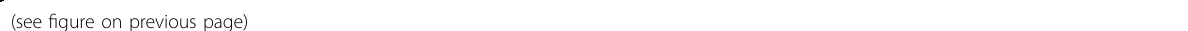
Fig. 5 Effect of C3G knock-down on EGFR activity and membrane localization. U87 and U87shC3G cells were used. A Representative western- blot analysis of phosphorylated and total levels of EGFR, ERKs, p38MAPK, and Akt proteins normalized to β -actin. Densitometric quanti fi cation of these proteins versus β -actin expressed as the fold increase of the value of untreated cells from the corresponding genotype (non-silenced and C3G silenced) ( n = 3). Untreated shC3G versus non-silenced cells ratios are: P-EGFR/ β -actin = 1, P-Akt/ β -actin = 2, P-ERKs/ β -actin = 1.6, P-p38MAPK/ β -actin = 2.6. Serum-starved cells (for 16 h) were stimulated with EGF for 5 – 60 min or maintained untreated. B Invasion through Matrigel in response to EGF. Upper panel, representative phase contrast microscopy images of invading cells; lower panel, histogram showing the mean value ± S.E.M. of the total number of invading cells ( n = 3). Scale bars: 100 µm. C Top panel, representative fl uorescence microscopy images of EGFR endocytosis mediated by EGF labeled with Alexa 488 (EGF-A488, green ) at different time points; lower panel, graph represents fl uorescence integrated density (ID) mean values ± S.E.M. ( n = 5 – 6). Scale bars: 50 µm. D and E Flow cytometric analysis of cell surface EGFR levels. D Cells were maintained in the presence (10% FBS) or absence of serum (0% FBS). E Cells were treated with EGF for 2 h to induce endocytosis or maintained untreated. Histograms show the percentage of cells presenting EGFR in the membrane (mean value ± S.E.M. ( n = 6)). * p ≤ 0.05 and ** p ≤ 0.01, compared as indicated. F Effect of recycling inhibition on cell surface EGFR levels analyzed by fl ow cytometry. Cells were maintained untreated or treated with monensin (Mon) (10 μ M, 1 h), EGF (2 h) or both (EGF + Mon). Histogram showing the mean value ± S.E.M. of the percentage of cells presenting EGFR in the